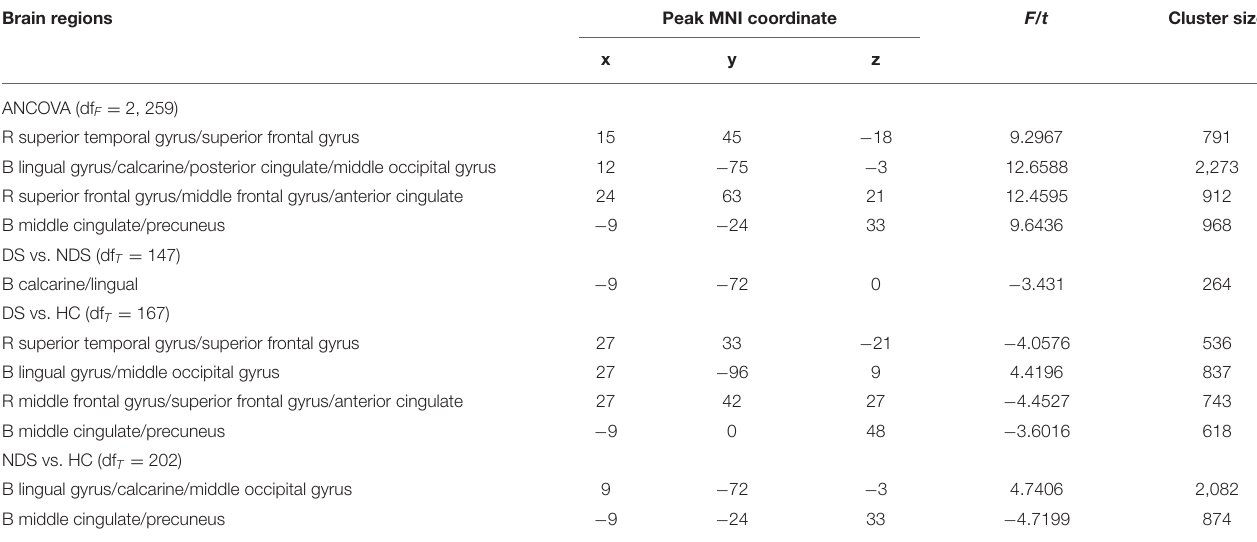
TABLE 3 | Altered regions of FC in the left NAcc network based on ROI analysis. Brain regions